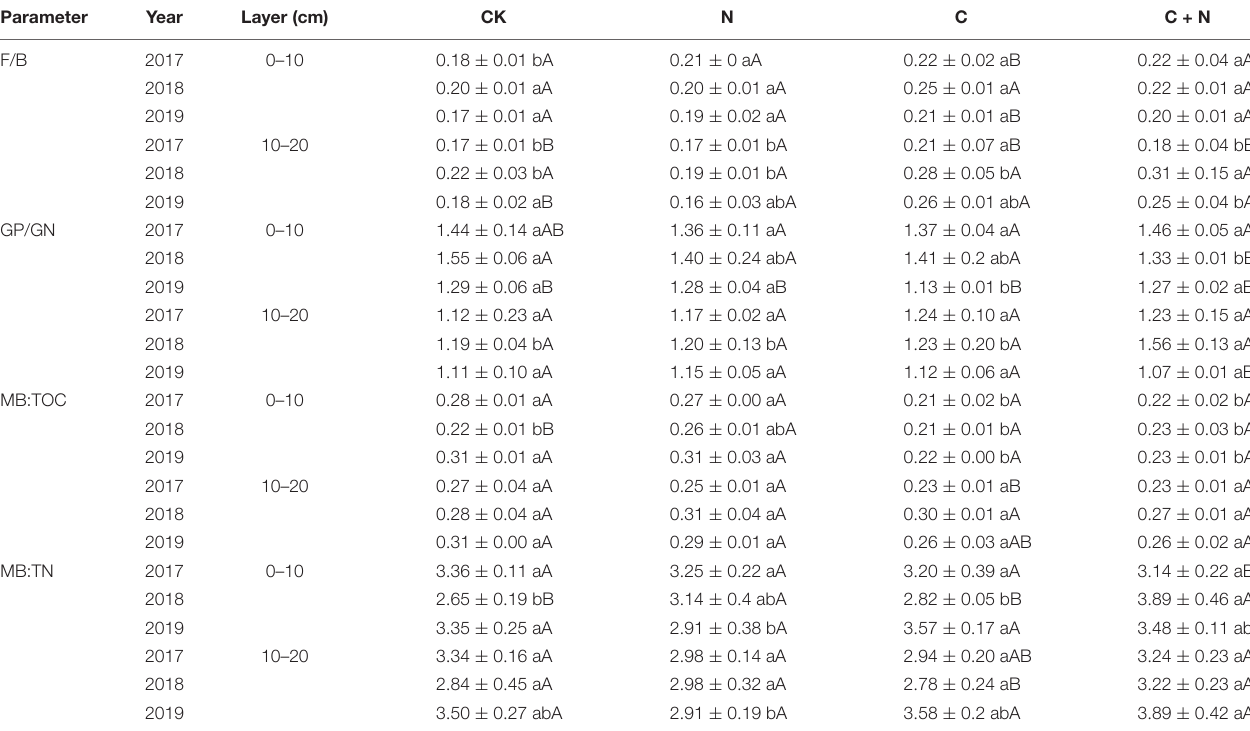
Values are means ± SE, lowercase letters indicate differences between different treatments in the same year (P < 0.05), and uppercase letters indicate differences between different years in the same treatment (P <